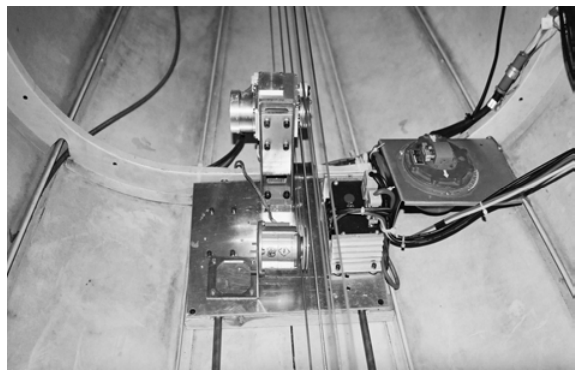
Fig 11. Elevator positioning during flight tests (03-10-24, start: 08:47:59); solid – deflection, dotted – desired value